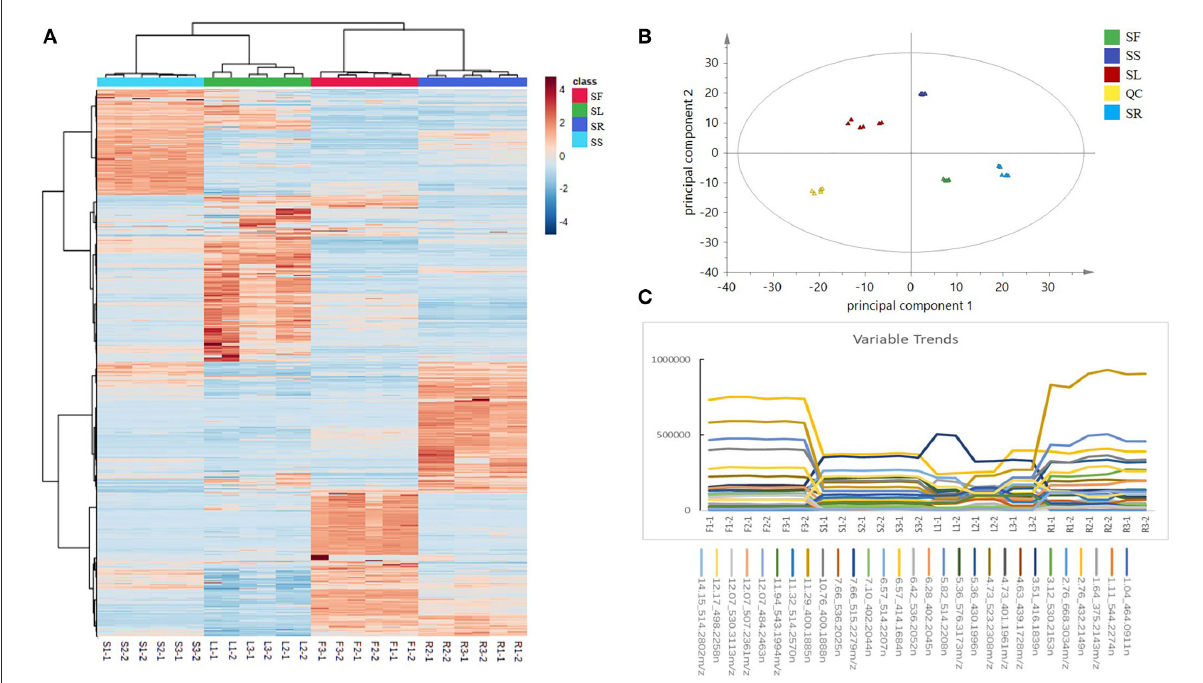
FIGURE3 (A) A heatmap based on the relative abundance of 3,302 identified compounds in different parts of Schisandra chinensis . (B) A PCA score plot of five parts of S. chinensis : stem (SS), leaf (SL), fruit (SF), root (SR), and quality control (QC). (C) Examples of variation trends of different compounds in different parts of S. chinensis .